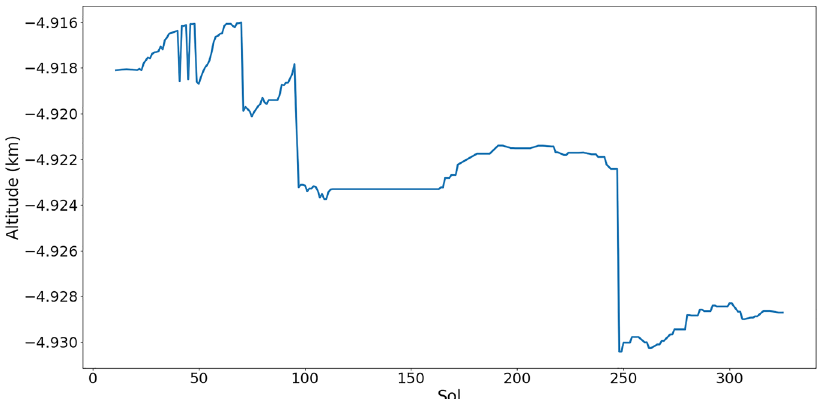
Figure 2. The altitude of the Zhurong rover changes during its first 325 sols mission